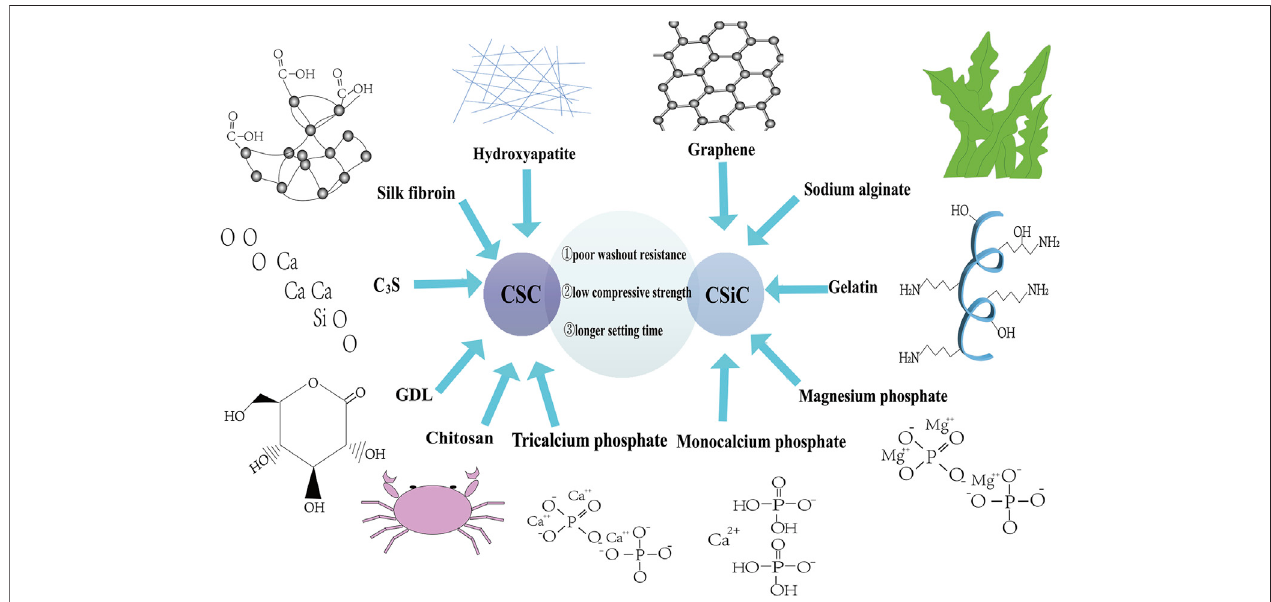
FIGURE 4 | Disadvantages of CSC and CSiC and their modi fi cations. CSC, calcium sulfate cement; CSiC, calcium silicate cement; C 3 S, tricalcium silicate; GDL, glucono-delta-lactone.